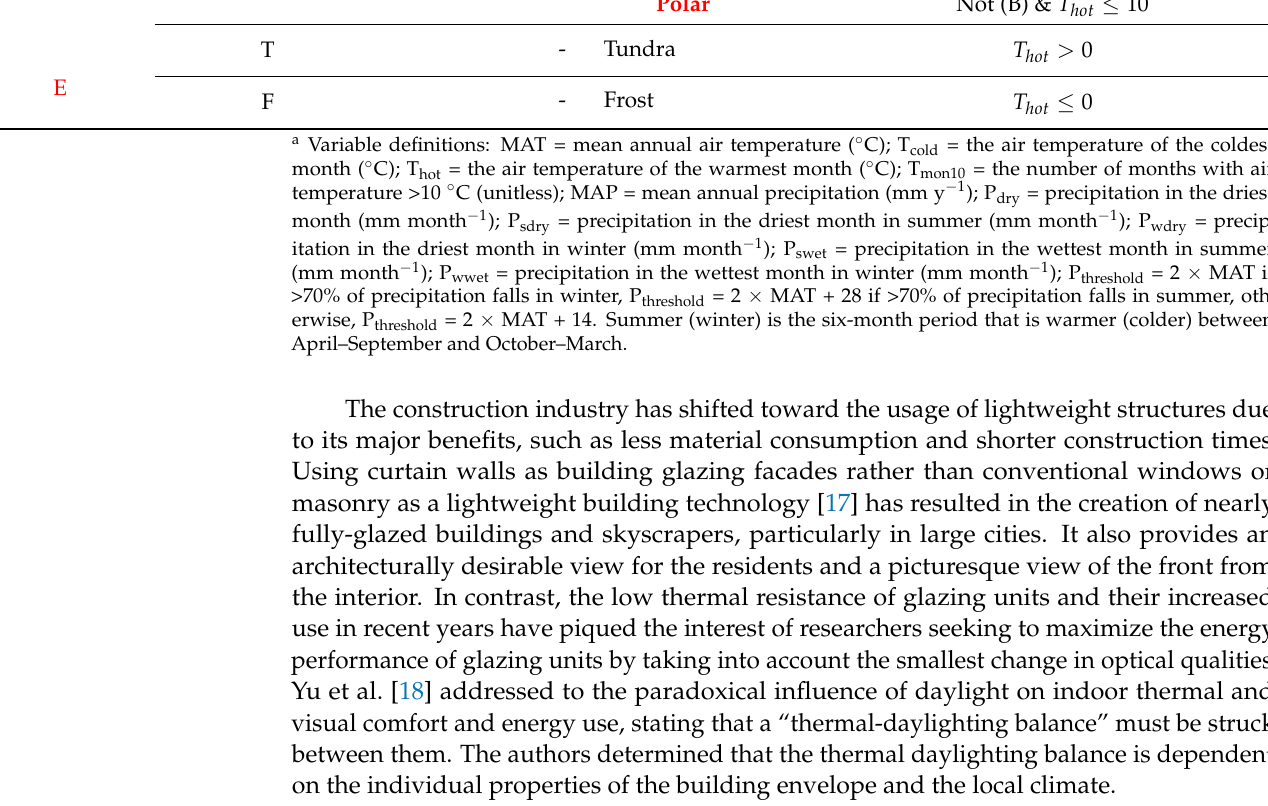
Table 1. Cont. 3rd Description Criterion a